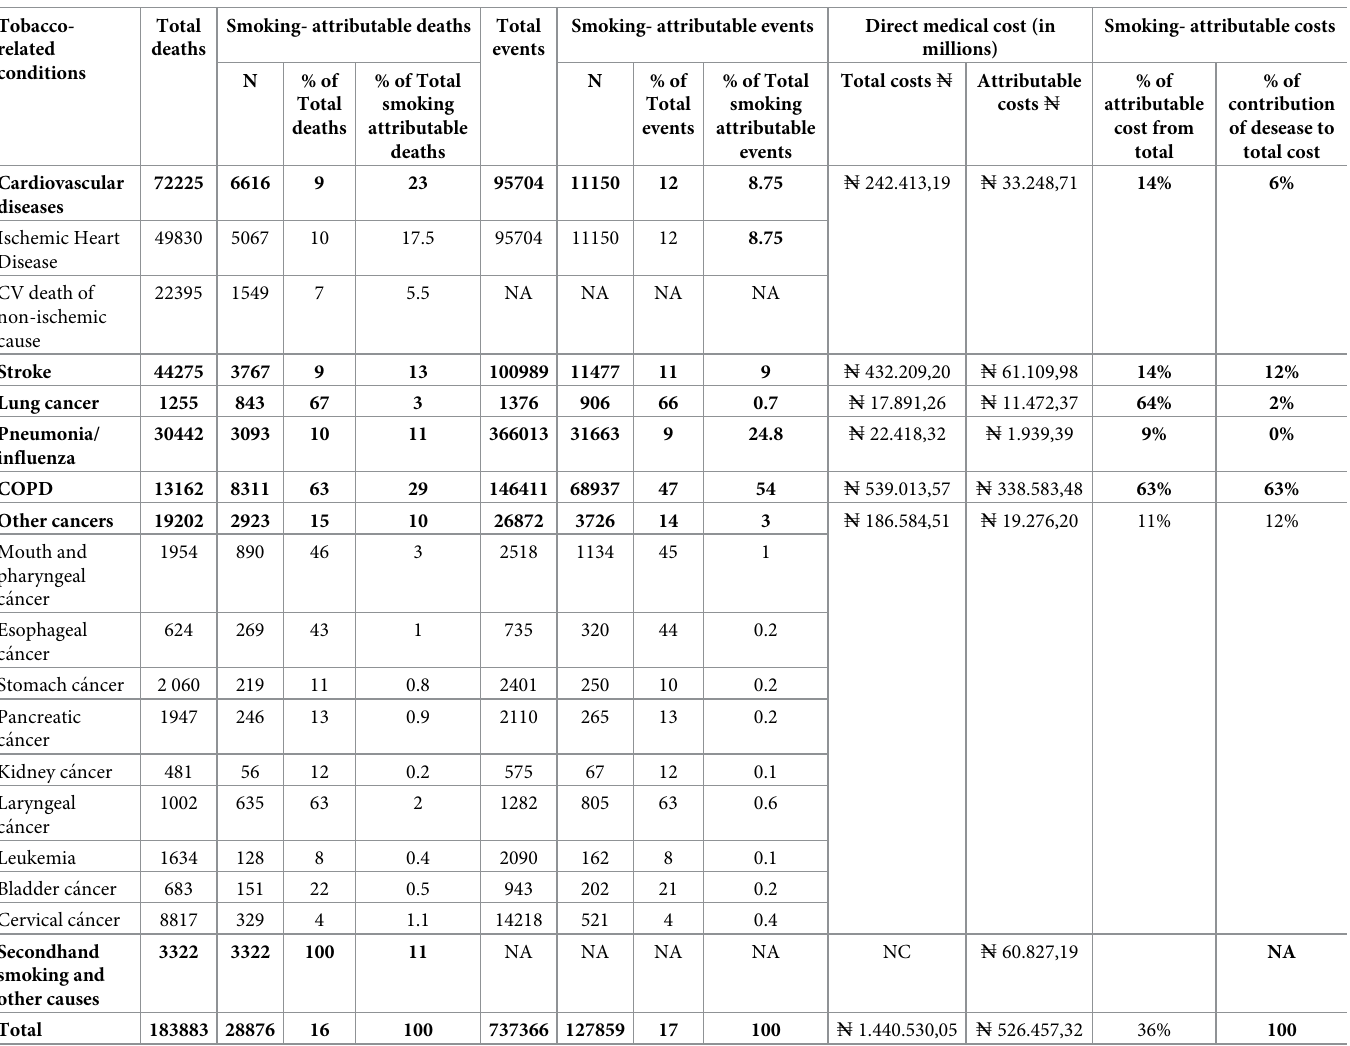
Table 3. Smoking-attributable deaths, events, and directs